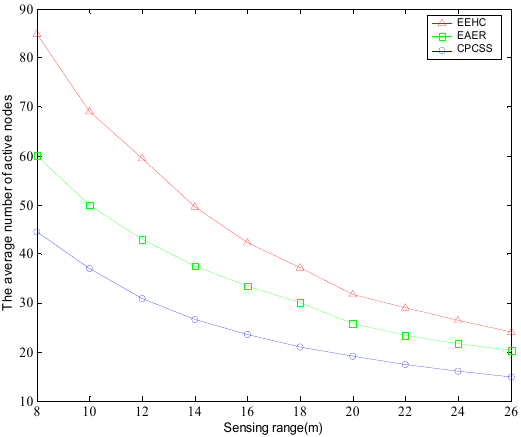
Figure 13. The average number of active nodes versus sensing range.